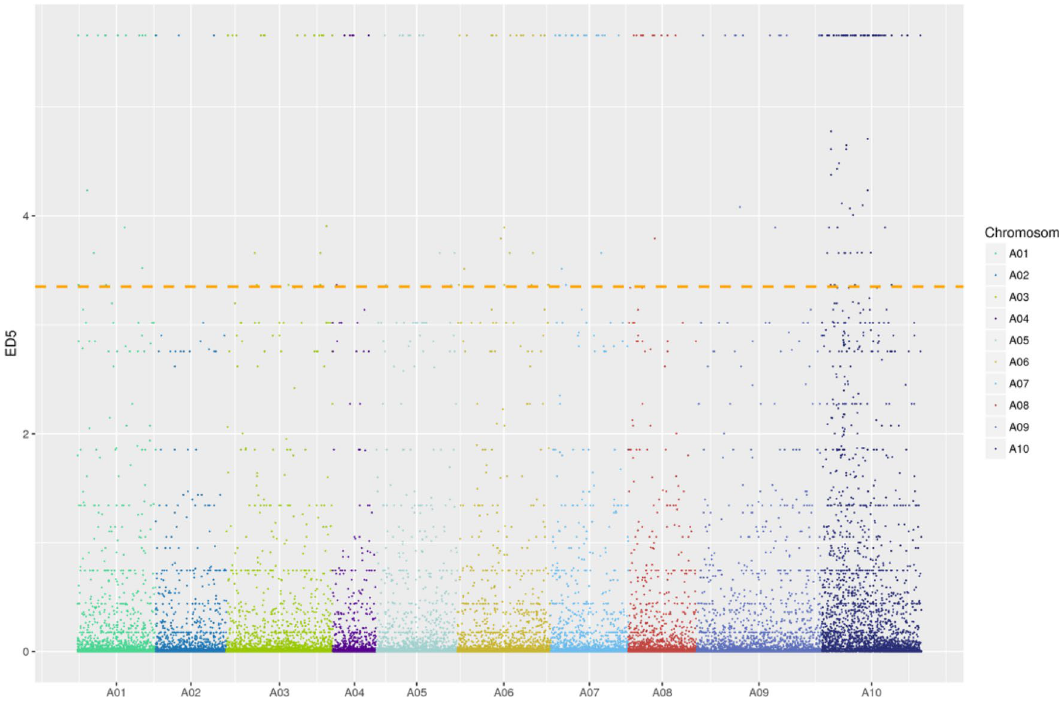
Figure 2. The distribution of ED 5 values on